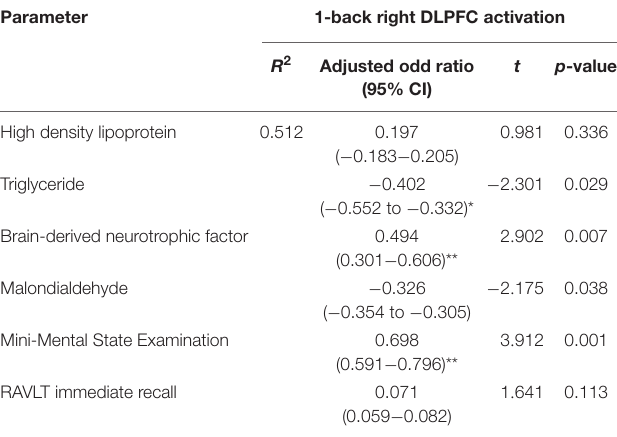
TABLE 4 | Multiple linear regression model of biochemical profiles, biomarkers, cognitive tests, and DLPFC